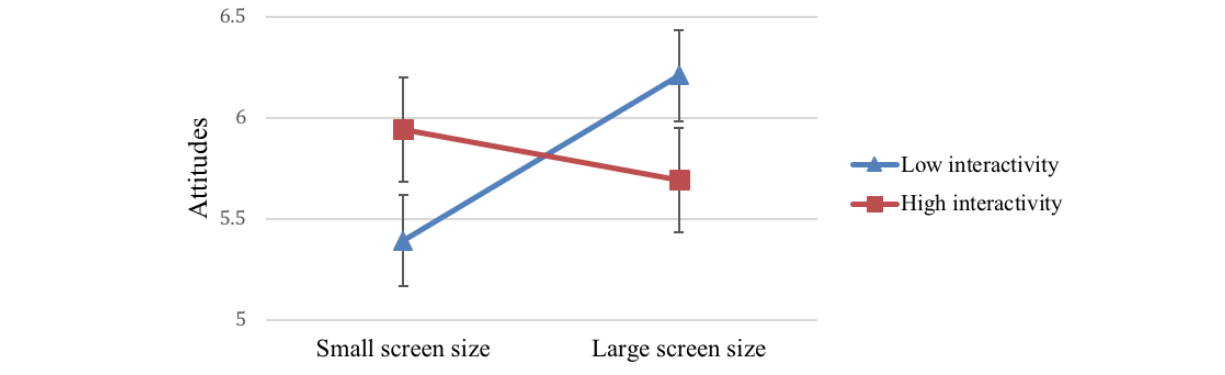
Figure 7. Two-way interaction of screen size and interactivity on